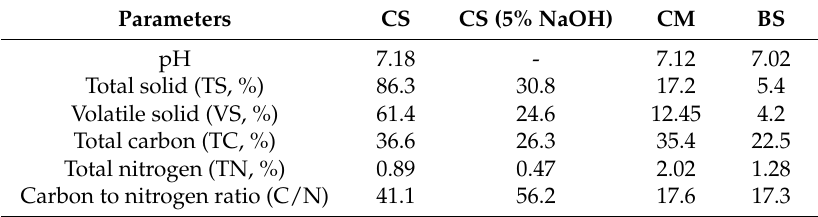
Table 1. The basic characteristics of corn straw (CS), cow manure (CM), and inoculum.